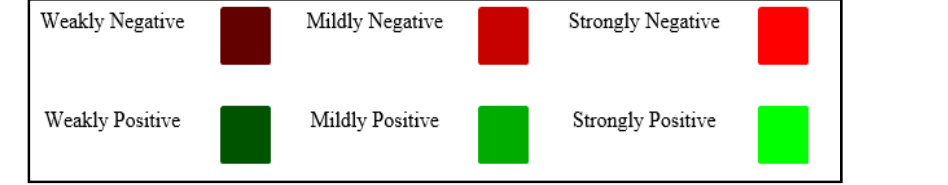
Figure 16. Color scale. Figure 15. Proposed Tree Map Visualization of Digital Camera 1.